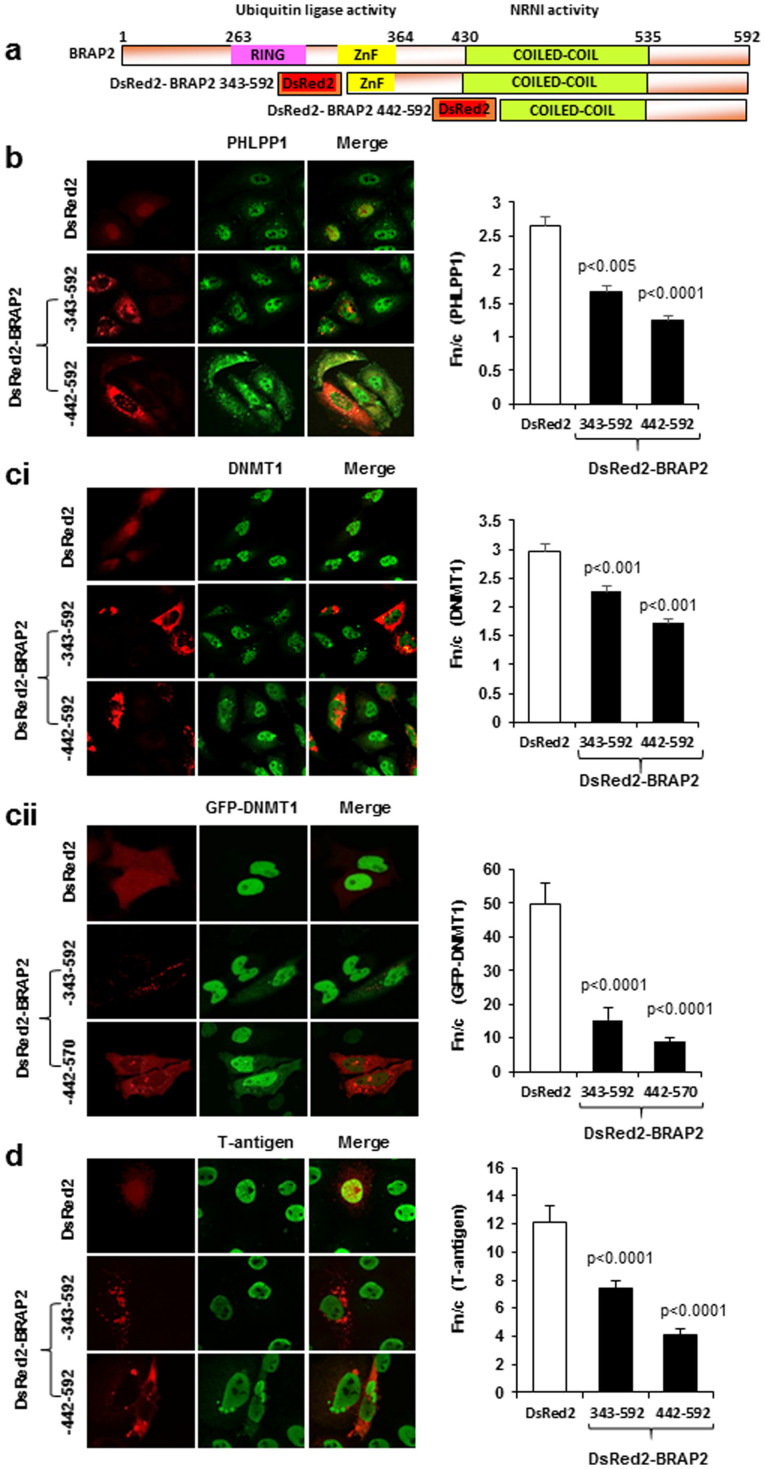
BRAP2 can acts as cytoplasmic retention factor for PHLPP1 and DNMT1.(a) Schematic representation of domain structure of BRAP2 and DsRed2 fused BRAP2 343–592 and 442–592. Amino acid residue numbers are indicated (top) Ring domain = 263–303; Zinc-finger ubiquitin binding domain (ZnF UBP) = 315–364; Coiled coil domain = 430–535. (b) CLSM images of HeLa cells transfected to express DsRed2 vector or DsRed2 fused BRAP2 constructs (as indicated) followed by fixation 20 hours post transfection and immunostained for endogenous PHLPP1 (left panels). Quantitative analysis on digitized CLSM images (right panel) to determine the Fn/c ratio (nuclear to cytoplasmic fluorescence ratio, above background) for endogenous PHLPP1 protein in presence and absence of indicated DsRed2 fused proteins. Values represent the mean +/− SEM (n > 30), with p values (Student's t test) shown where there were significant differences between values in absence or presence of the BRAP2 constructs (right). (ci) As per (b), CLSM images of HeLa cells immunostained with DNMT1 antibody in presence or absence of ectopically expressed DsRed2 fused BRAP2 constructs (as indicated on panels) or DsRed2 vector (left) together with quantitative analysis (right panel). (cii) As per (b), CLSM images of live HeLa cells co-transfected for ectopic expression of GFP-DNMT1 with DsRed2 or DsRed2 fused BRAP2 343–592 and 442–570 post 20–24 hours (left), together with quantitative analysis (right panel). (d) As per (b), CLSM images of Cos7 cells immunostained with T-ag antibody in presence or absence of ectopically expressed DsRed2 fused BRAP2 constructs (as indicated on panels) or DsRed2 vector (left) together with quantitative analysis (right panel).